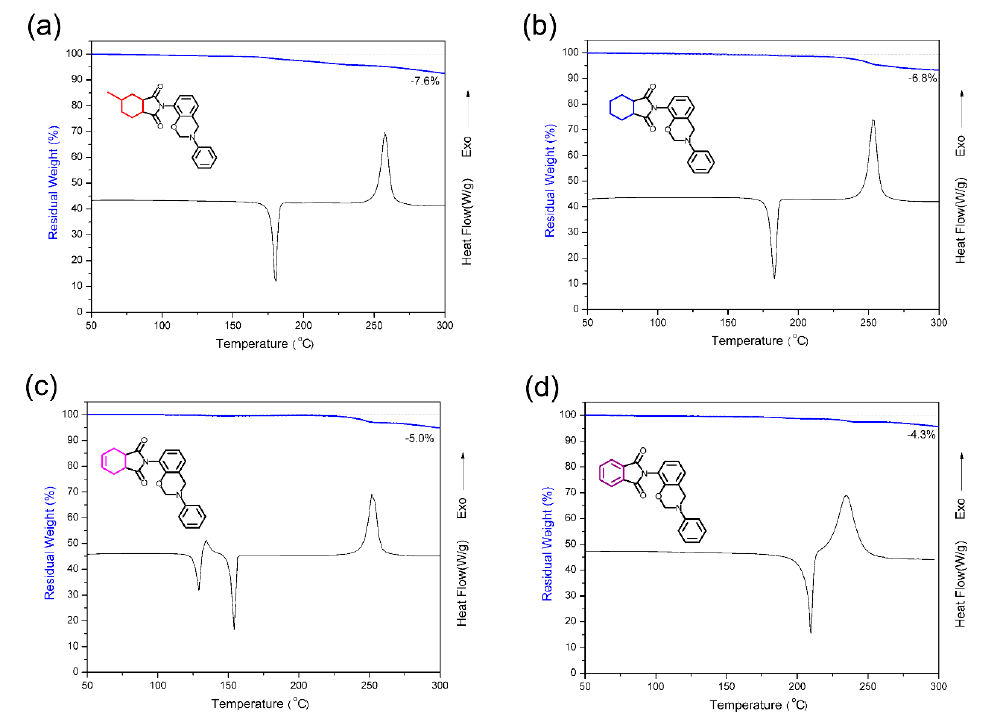
Figure 6. TGA vs DSC plots of benzoxazine monomers (heating rate: 10 °C/min, under a N 2 a ) o MHI-a, ( b ) o HHI-ac, ( c ) o HTI-a, and ( d ) o PP-a. atmosphere): ( a ) o MHI-a, ( b ) o HHI-ac, ( c ) o HTI-a, and ( d ) o PP-a. atmosphere): (